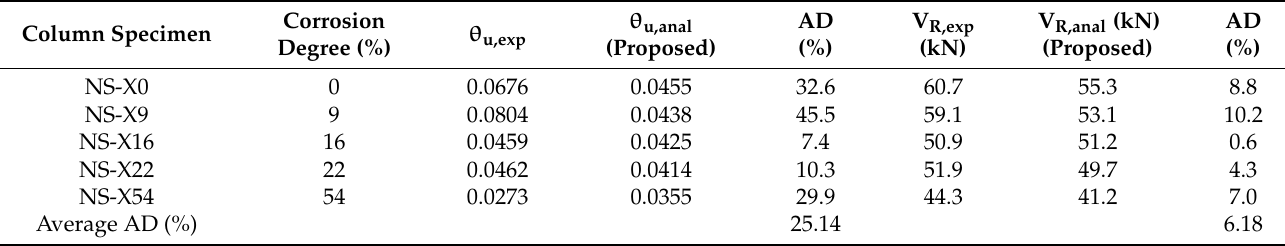
Table 4. Comparison of analytical and experimental values of θ u and V R